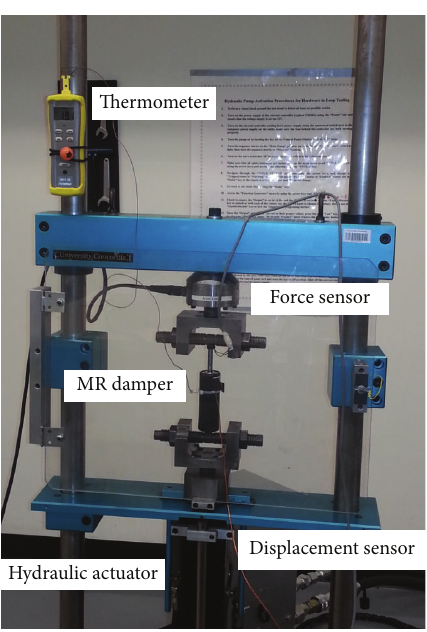
Figure 3: MR damper and hydraulic shaker.